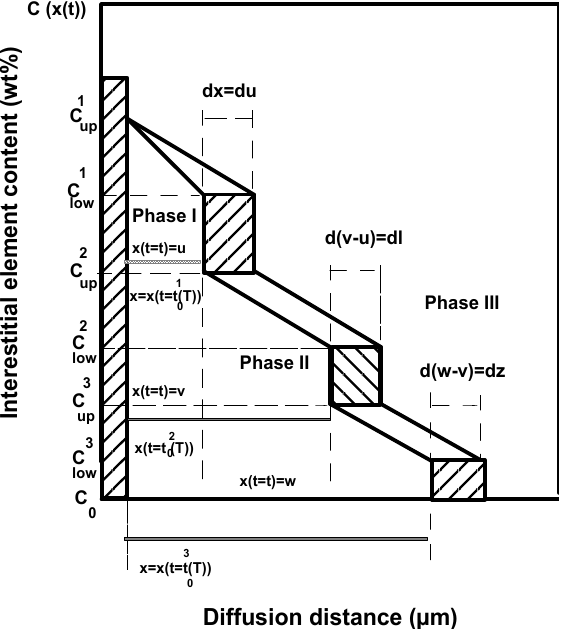
Diffusion distance (µm) Figure 1. Schematic representation of interstitial element concentration profile inside a system of three phases.